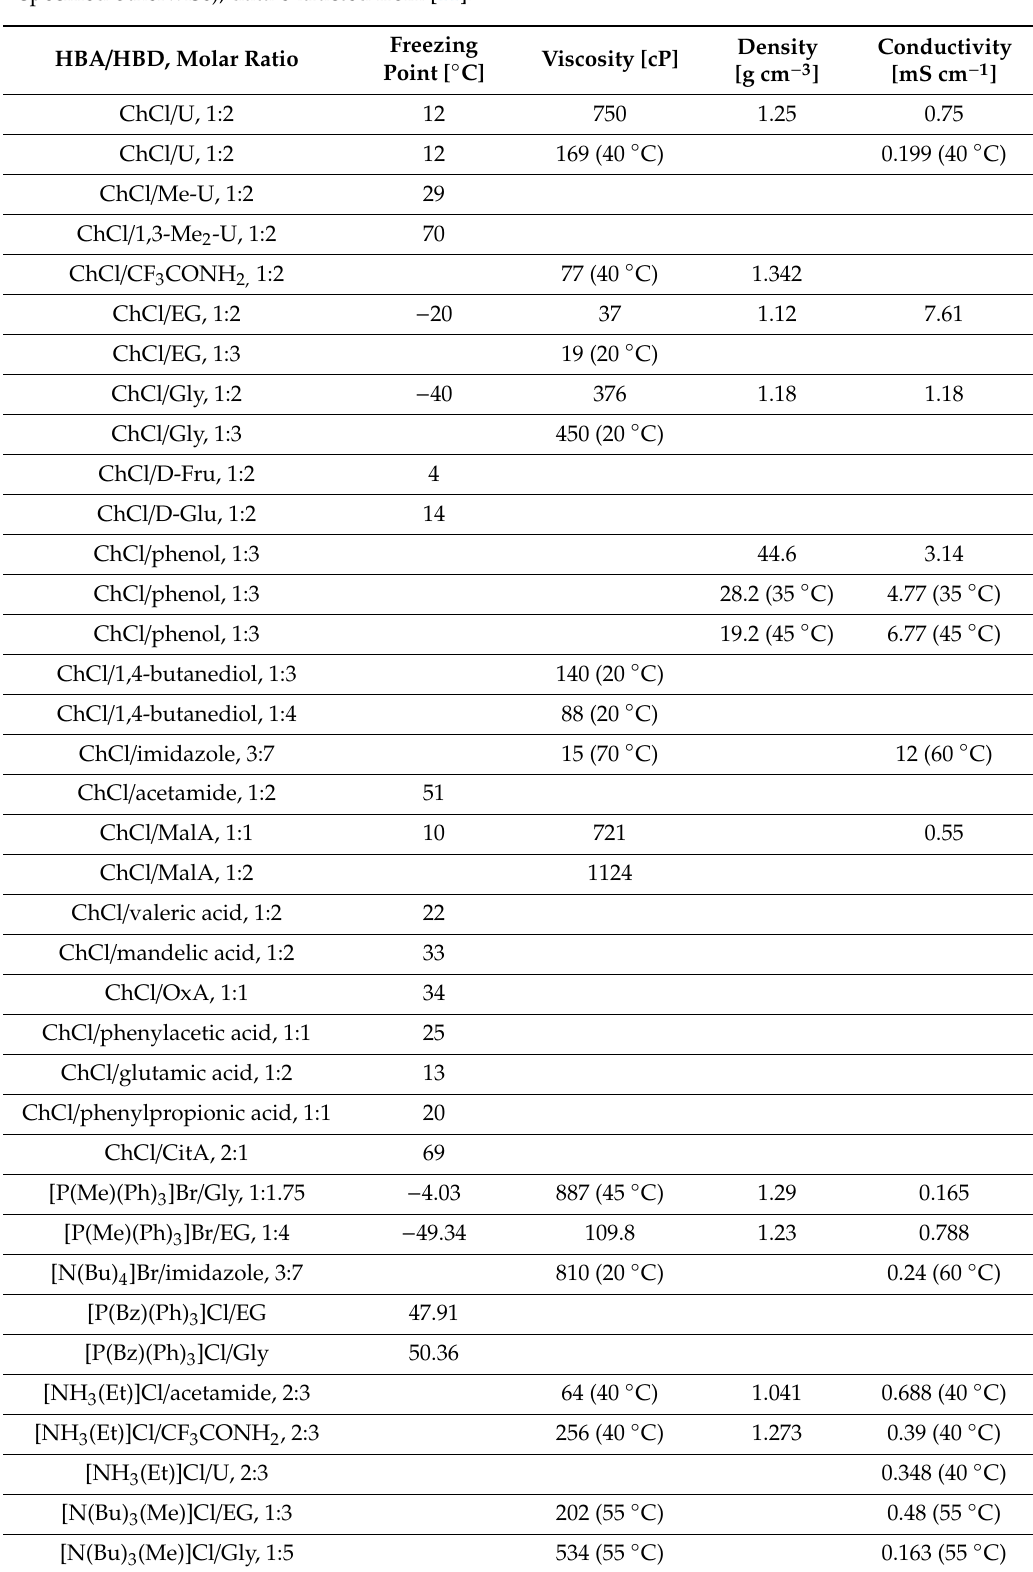
Table 2. Composition and physical properties of selected two-component Class III DESs at 298 K (if not specified otherwise); data extracted from